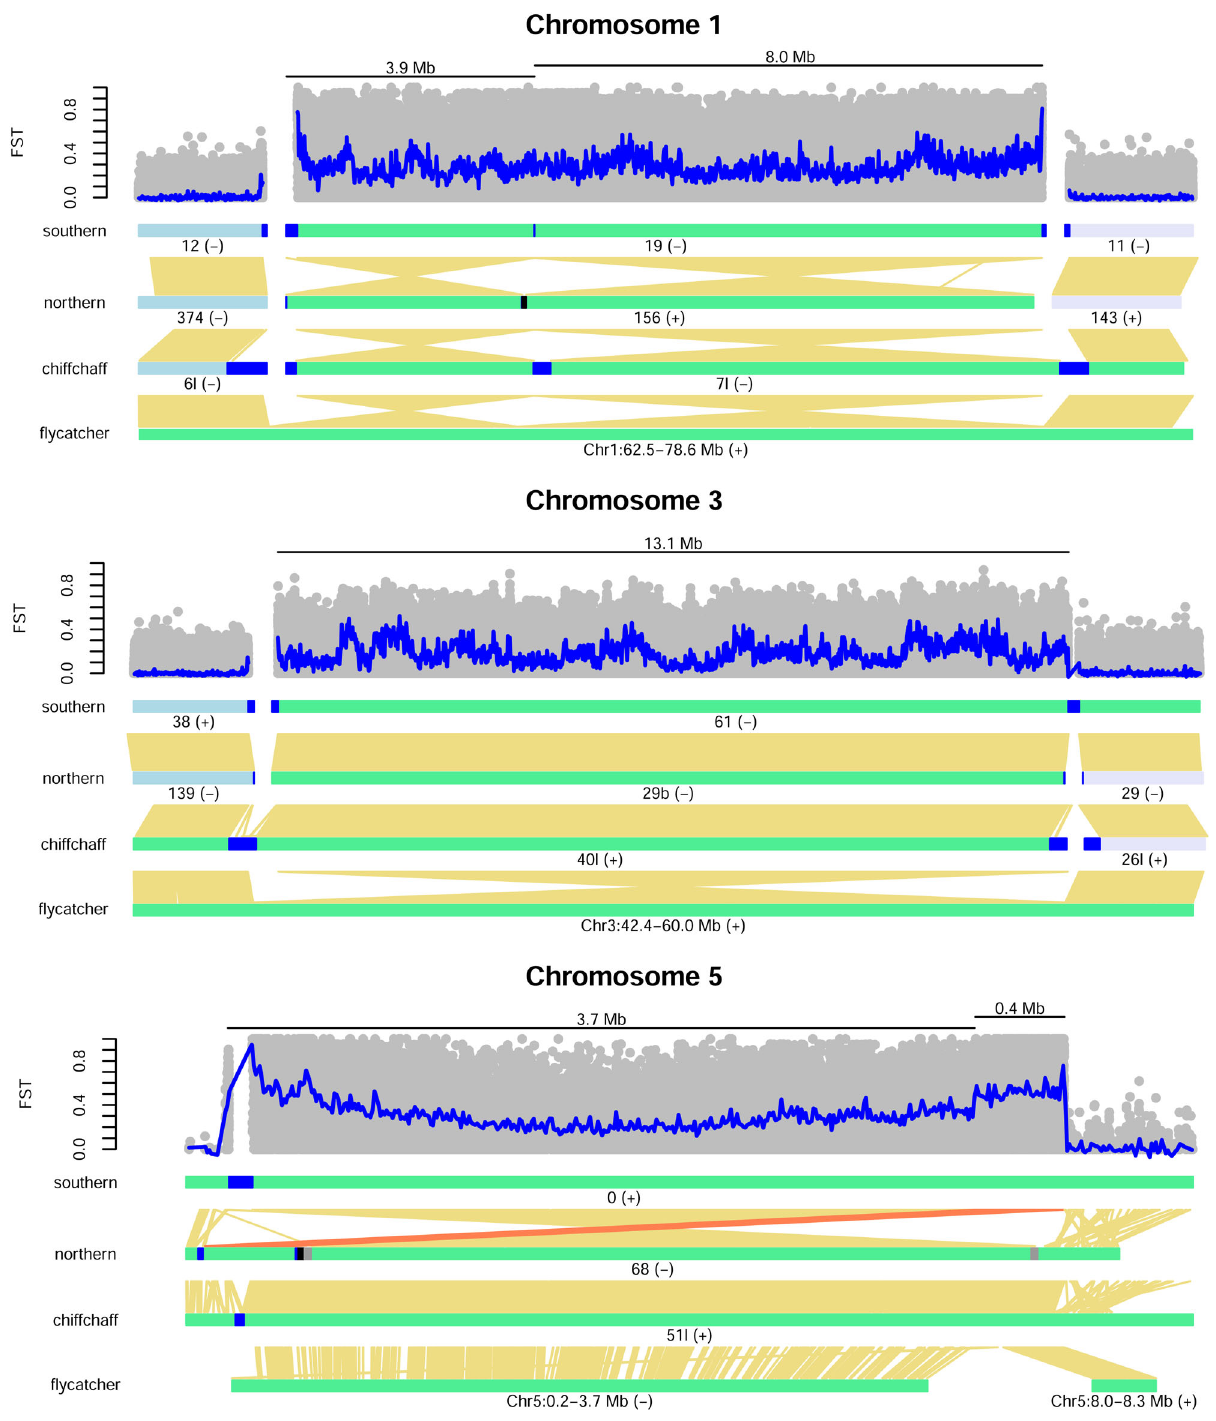
Fig.2|Divergentregionsonchromosome1,3,and5inthesouthernassembly. The top panelshows genetic differentiation(F ST ) between11 resequenced samples from each subspecies for variants with a minor allele frequency (MAF) ≥ 0.1, with blue lines representing a weighted average for MAF ≥ 0.1 bi-allelic SNPs in 10kb non-overlapping windows. Below, scaffolds or chromosomes (chr) in each assem- blymatchingthedivergentregionsareshownaslightgreenrectangles(withIDand plotted orientation) and predicted upstream and downstream scaffolds as light blueandlightpurplerectangles,respectively.Bluesegmentsonscaffoldsshowthe